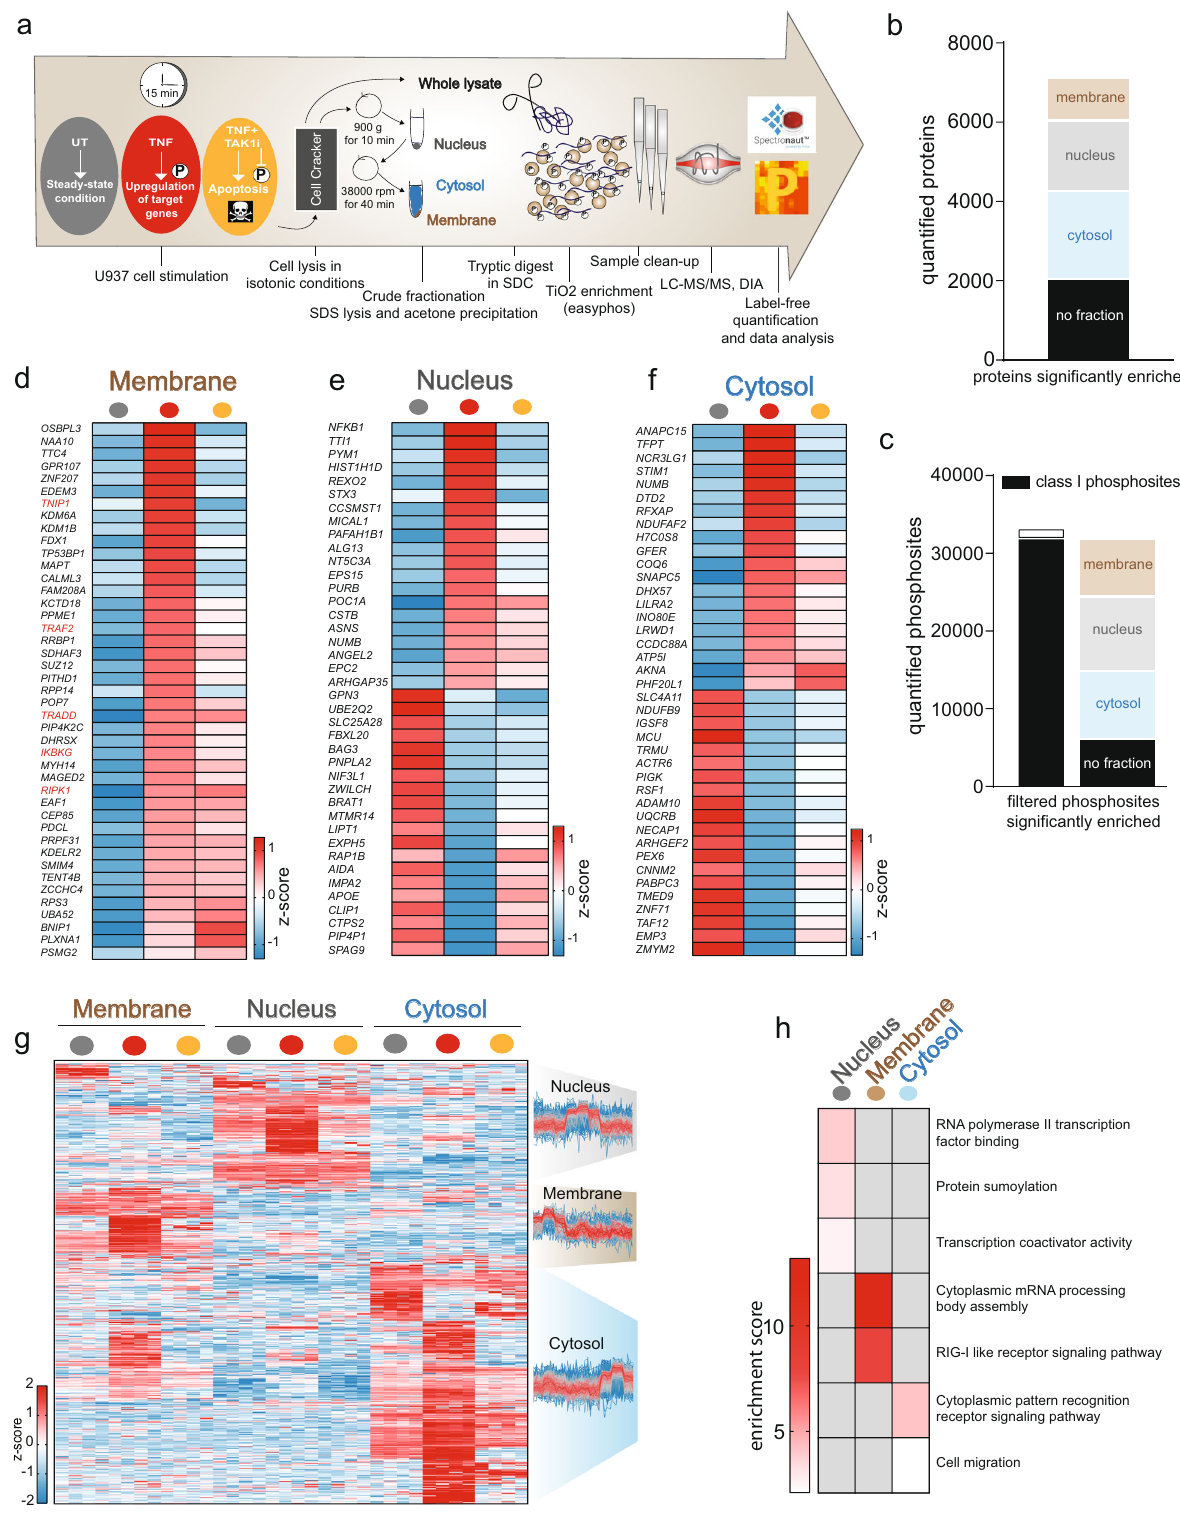
plasma-membrane permeabilization in U937 cells, and it caused a inhibition of the cell cycle during cell death (Fig. 4c; Supplemen- strong GTPase response in BMDMs (Fig. 4c; Supplementary tary Fig. 4n). Enrichment analysis on kinases whose phosphor- Fig. 4g). Proteome analyses in both cell lines revealed that ylation was regulated upon stimulation revealed regulation of stimulation-induced phosphoproteome changes did not correlate cyclin-dependent protein kinases during apoptosis (Fig. 4d). with proteome changes (Supplementary Fig. 4j – m). Filtering for ANOVA signi fi cantly changing phosphosites on Phosphorylation of kinase motifs in CDK1, 4, 5, and 6 in CDKs upon stimulation, showed that transcriptional CDKs apoptotic and necroptotic cells was downregulated, suggesting (CDK7, 9, 12, 13, and 14) were regulated rather than CDKs NATURE COMMUNICATIONS| (2021) 12:6053